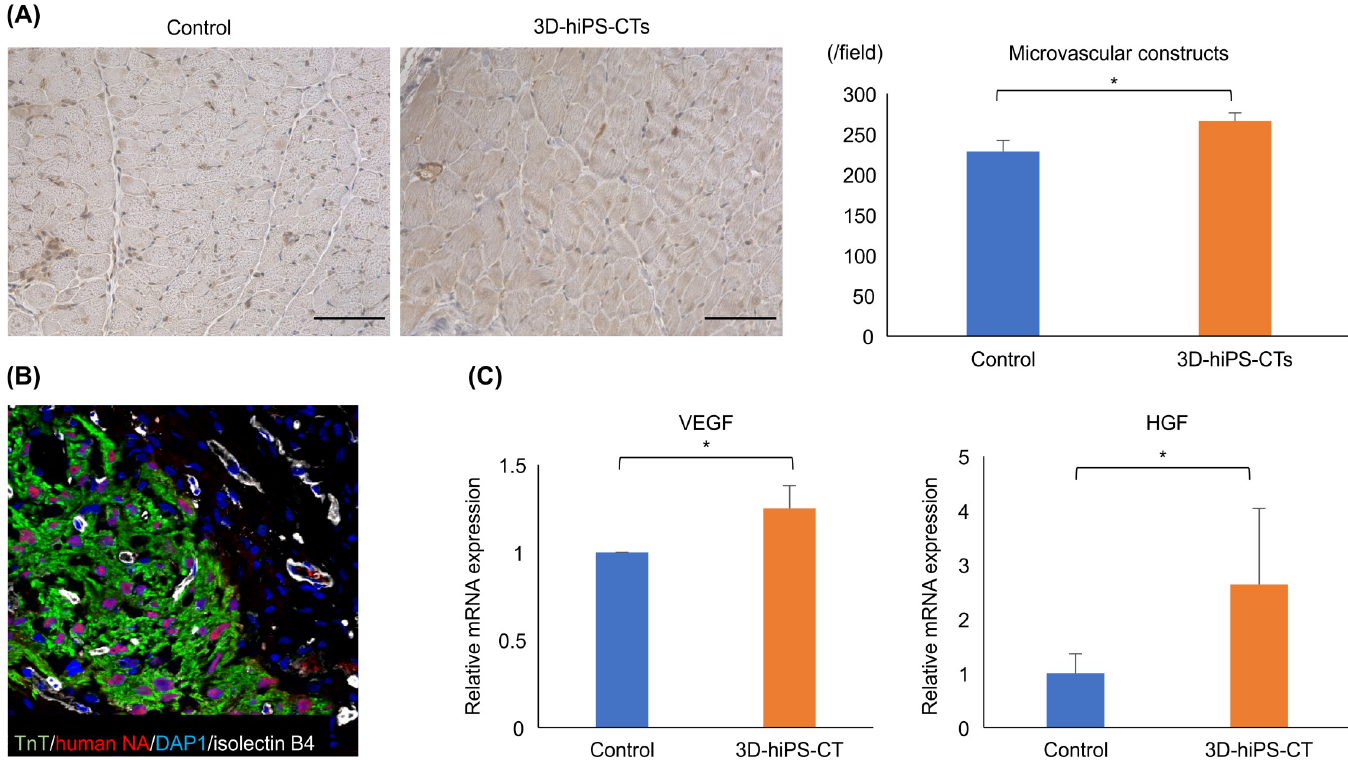
Fig 4. The three-dimensional human induced pluripotent stem cell-derived cardiac tissue (3D-hiPSC-CT) induced angiogenesis and angiogenic cytokine expression in the peri-infarct zone. (A) Capillary density in the peri-infarct zone in the myocardial infarction rat heart 4 weeks after transplantation; scale bar = 100 μ m. Sections were assessed by immunohistochemical staining for von Willebrand factor; � P < 0.01. (B) Immunostaining for isolectin B4 (white), TnT (green), human nuclei (red), and DAPI (blue); scale bar = 50 μ m. (C) Quantitative polymerase chain reaction analysis of angiogenic cytokine-related gene expression ( Vegf and Hgf : � P < 0.01.